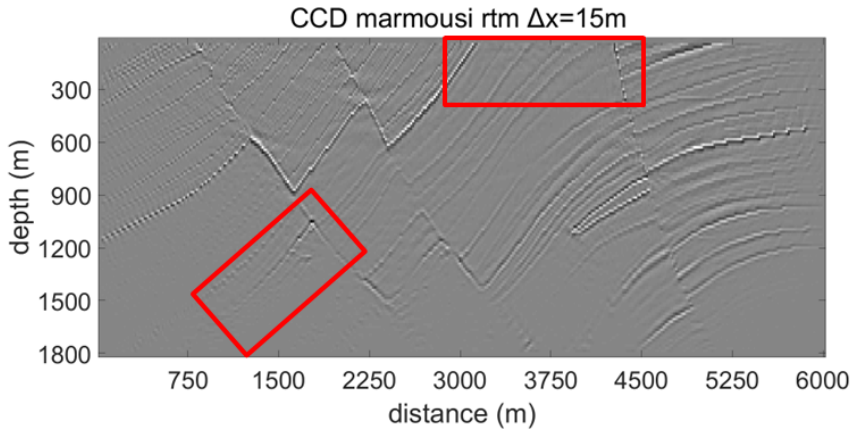
Figure 14. CCD is used to the reverse ‐ time migration result with Marmousi shear ‐ wave velocity model, Δ x = 15 m.